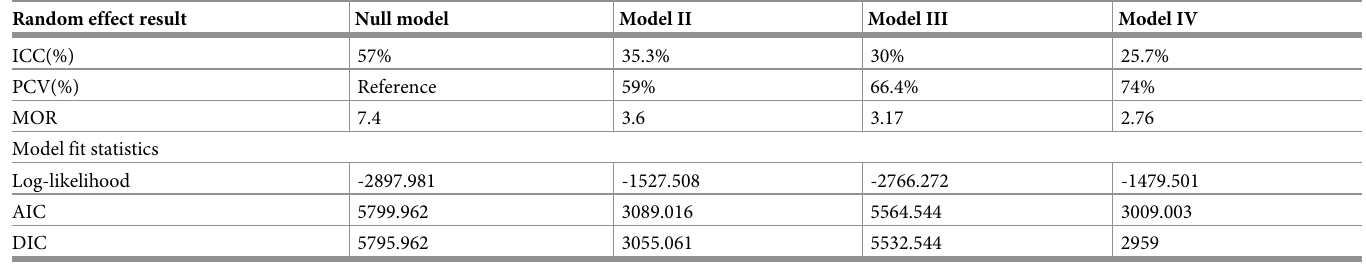
Table 4. Measures of variation (random intercept models) and model fit statistics in institutional delivery among women who had live birth in the last five years preceding 2019 EM